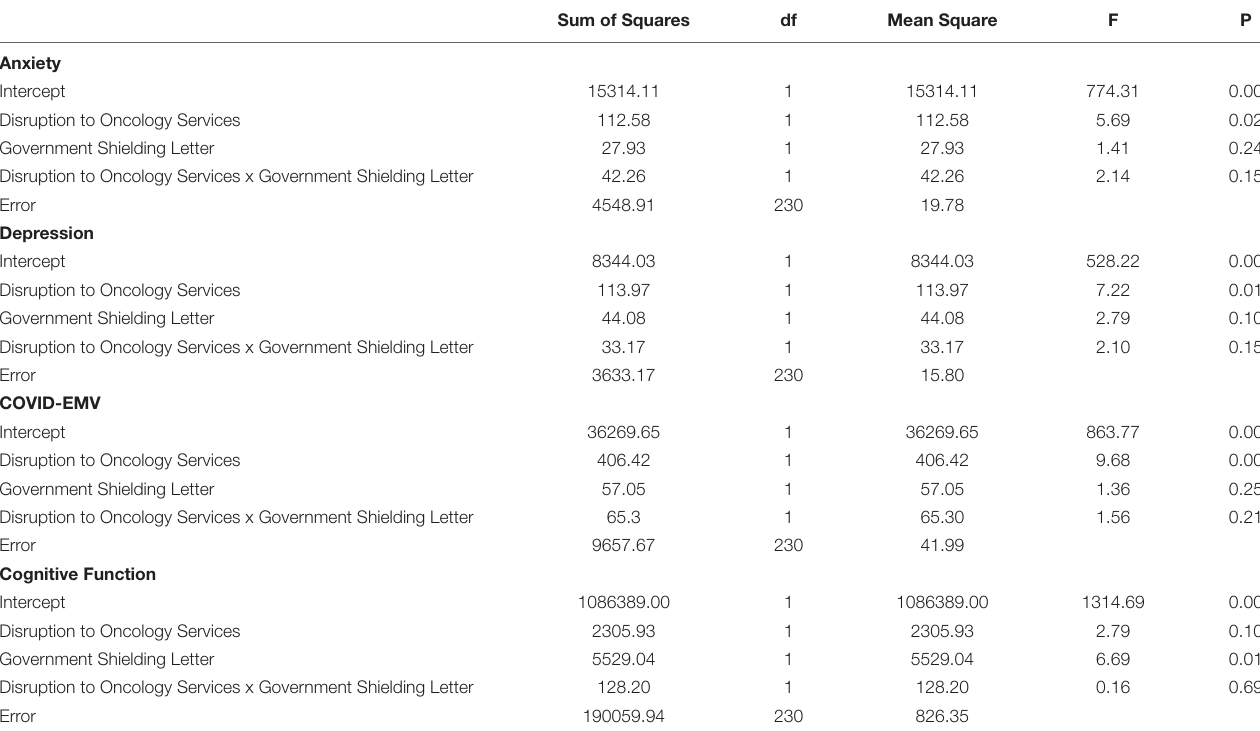
TABLE 3 | ANOVA results using disruption to oncology services and UK Government shielding letter as predictors. Sum of Squares df Mean Square F